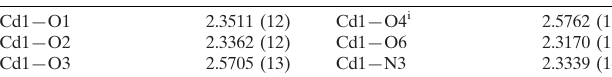
Data collection Bruker Kappa APEXII CCD area- detector diffractometer